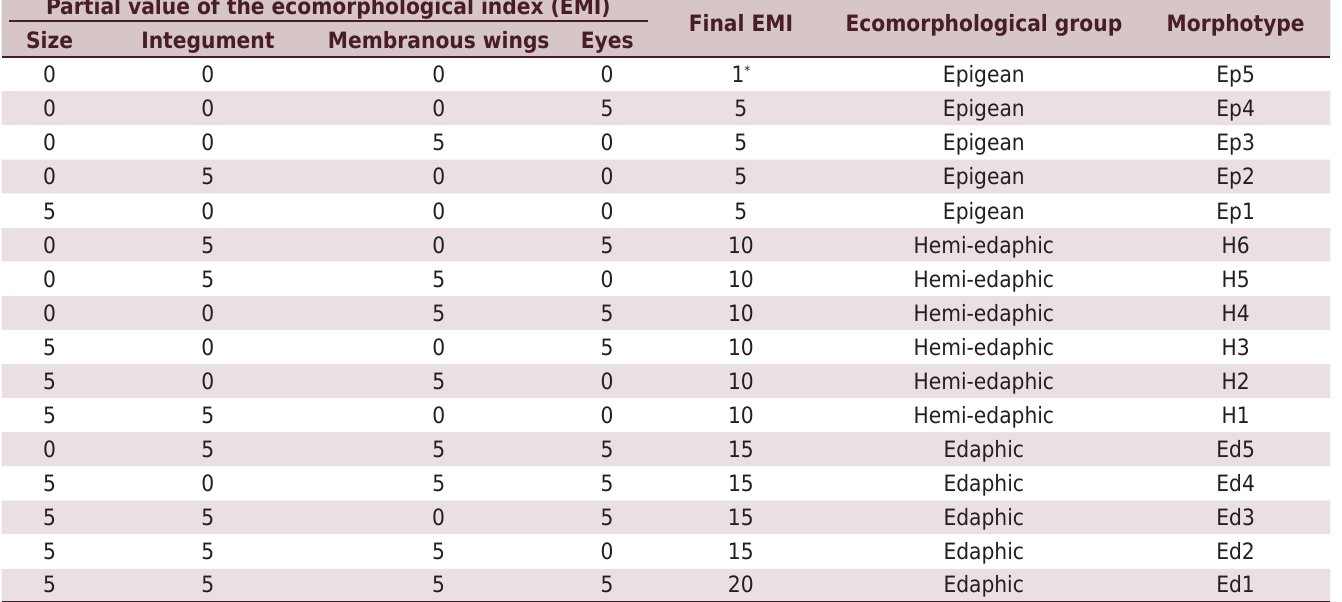
Table 3. Classification pattern of the categories of morphological Coleoptera traits Partial value of the ecomorphological index (EMI)